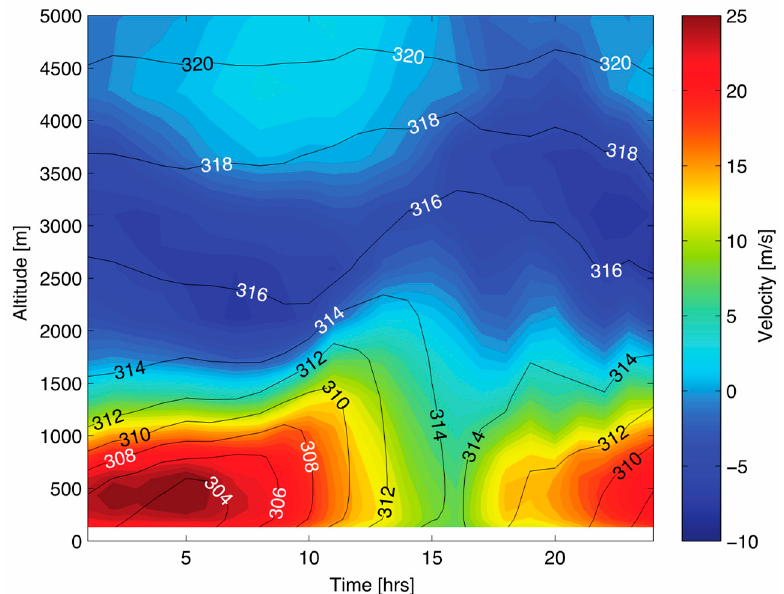
Figure 18. Hovmöller diagram for potential temperature and horizontal, along-thalweg wind velocity as a function of elevation over 12 July 2008. The data come from a location over the Tokar Delta, indicated by a triangle in Figure 1.